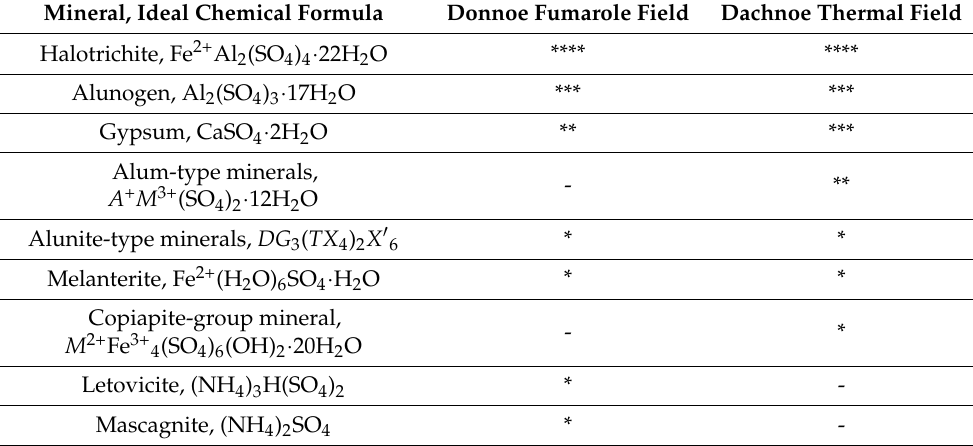
Table 1. Sulphate efflorescence minerals from Mutnovsky volcano detected by powder X-ray diffrac- tion